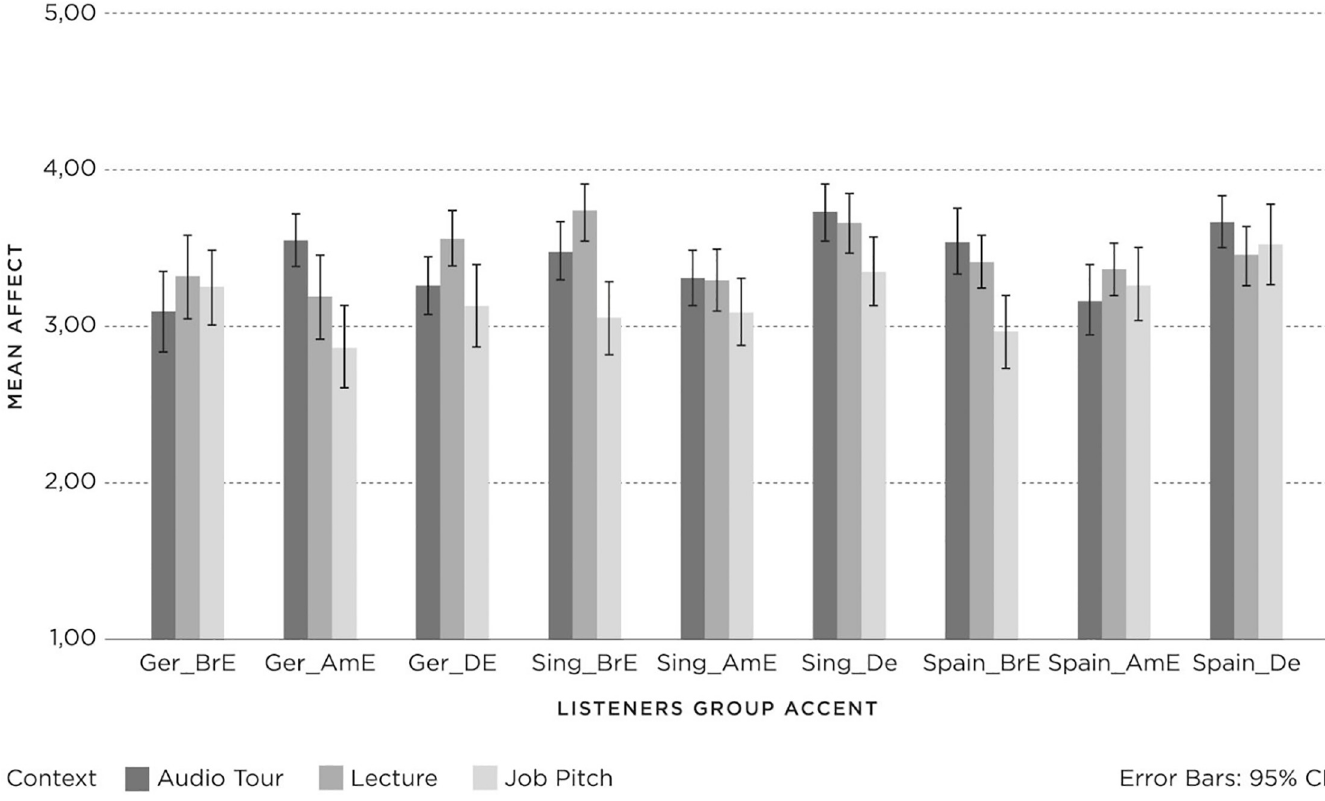
Fig 6. Affect (1 = negative; 3 = neutral; 5 = positive) for Listener groups (Germany (Ger), Spain, Singapore (Sing)) per accent (British English (BrE), American English (AmE), Dutch English (DE)) and context (Audio Tour, Lecture, Job Pitch).